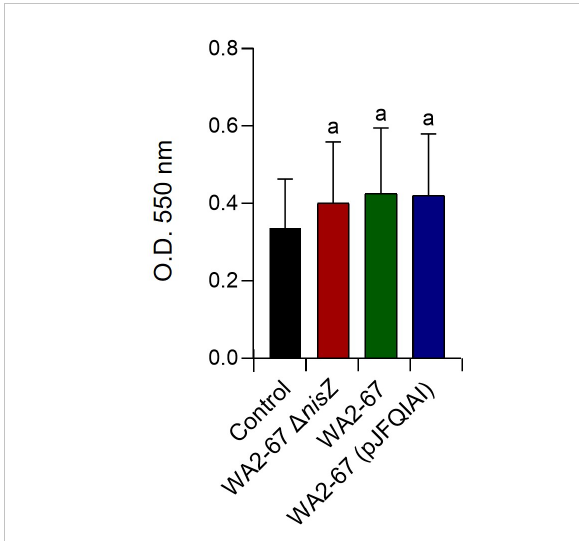
FIGURE 6 Effects of L. cremoris WA2-67 D nisZ , L. cremoris WA2-67 and L. cremoris WA2-67 (pJFQIAI) on the respiratory burst activity of splenocytes, via the reduction of the ferricytochrome c by released superoxide anion ( O − 2 ). Splenocytes were incubated with the different bacterial strains for 30 min at 20°C. Optical density (OD) was then measured at 550 nm. Data are shown as mean OD values + SD (n = 9). The letter (a) represents transcription levels signi fi cantly different than those observed in cells not exposed to bacterial strains (control).